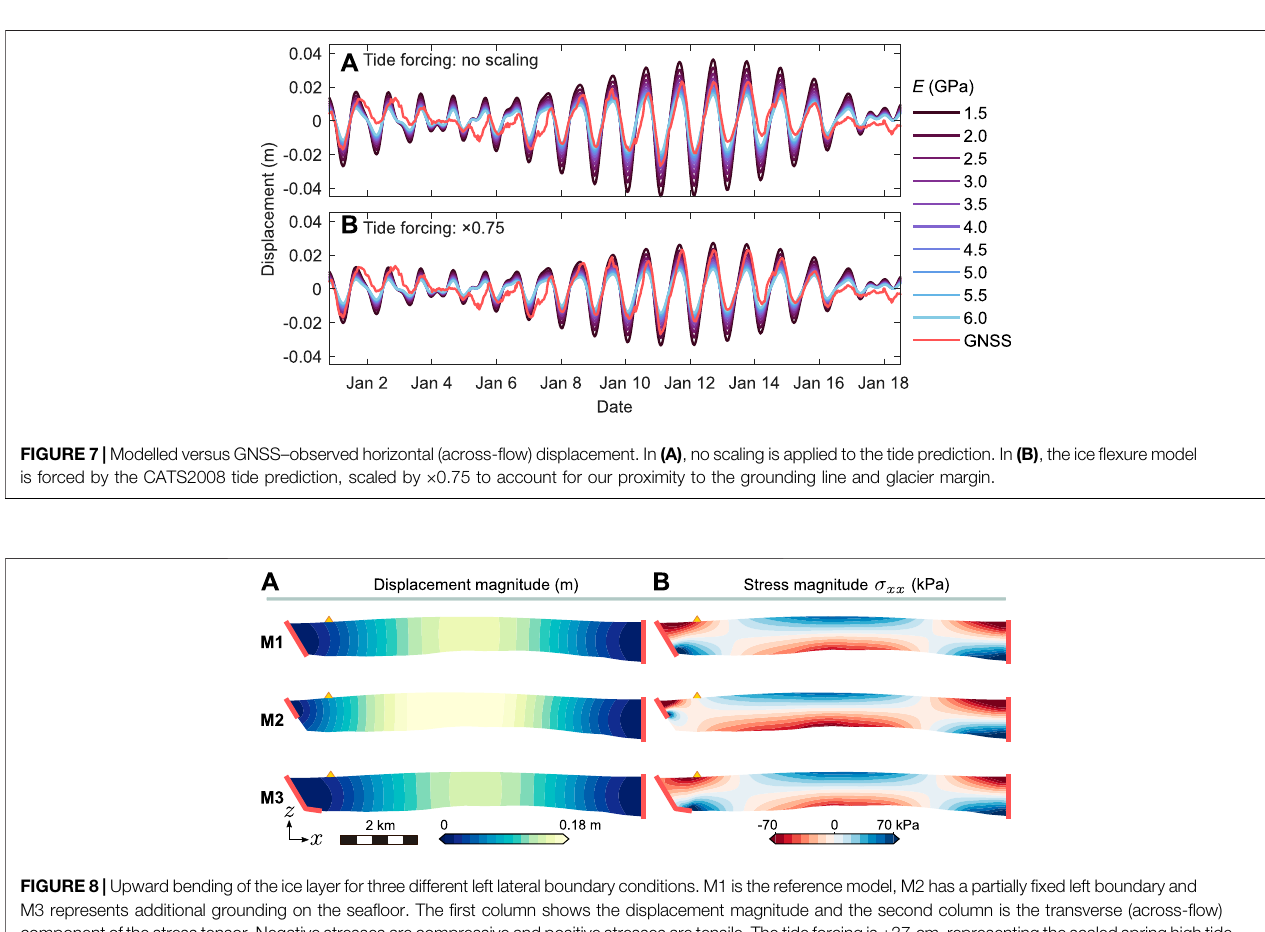
Frontiers in Earth Science |